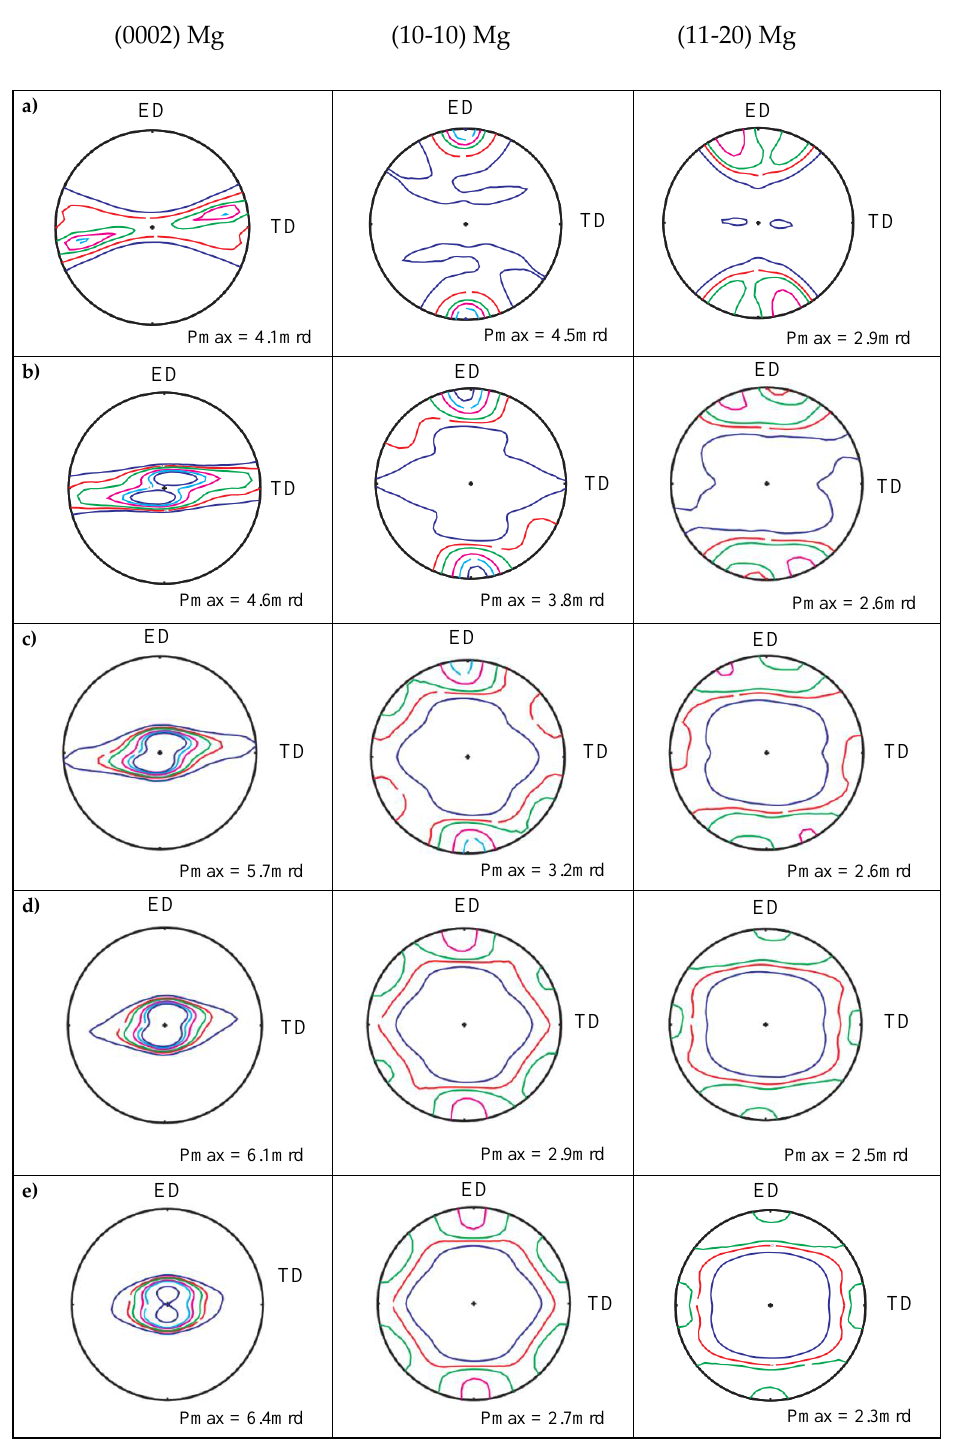
Figure 9. Texture gradients of the Mg-phase in Al60Mg40, presented by (0002), (10-10) and (11-20) Mg pole figures; ( a ) 1 mm, ( b ) 3.15 mm, ( c ) 5.3 mm ( d ) 7.45 mm and ( e ) 9.6 mm below the surface.